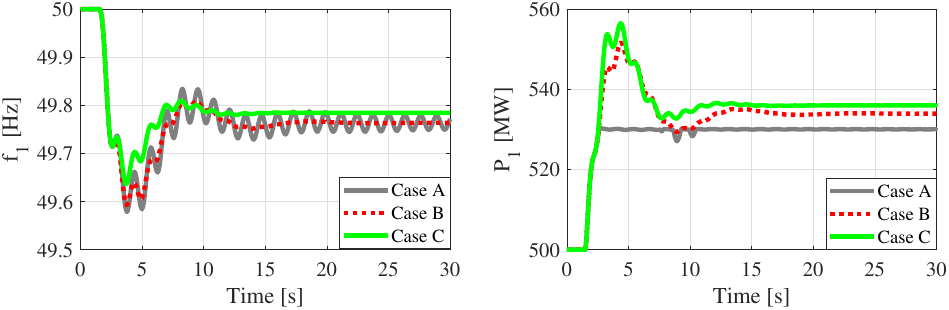
Figure 5. Onshore frequency, f 1 , and power fed by VSC1, P 1 , when using AFC from offshore